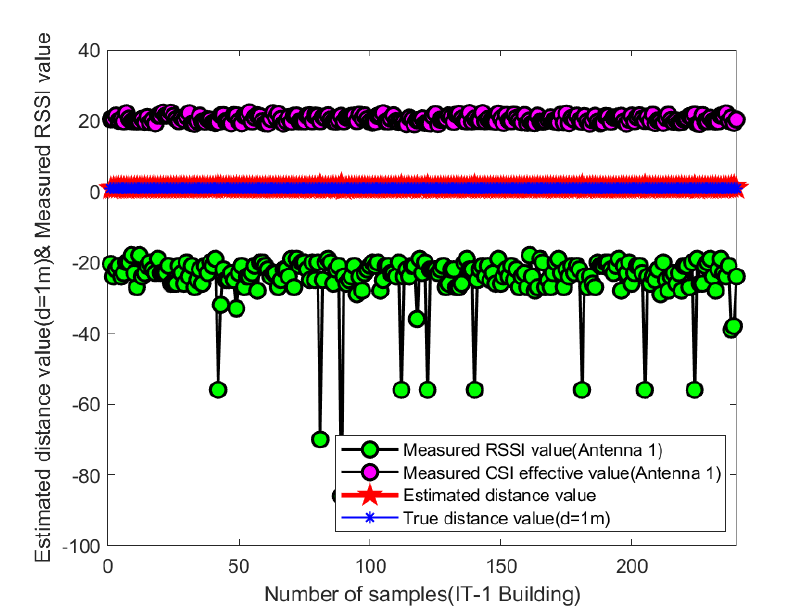
Figure 15. The accuracy of distance estimation (the proposed algorithm).